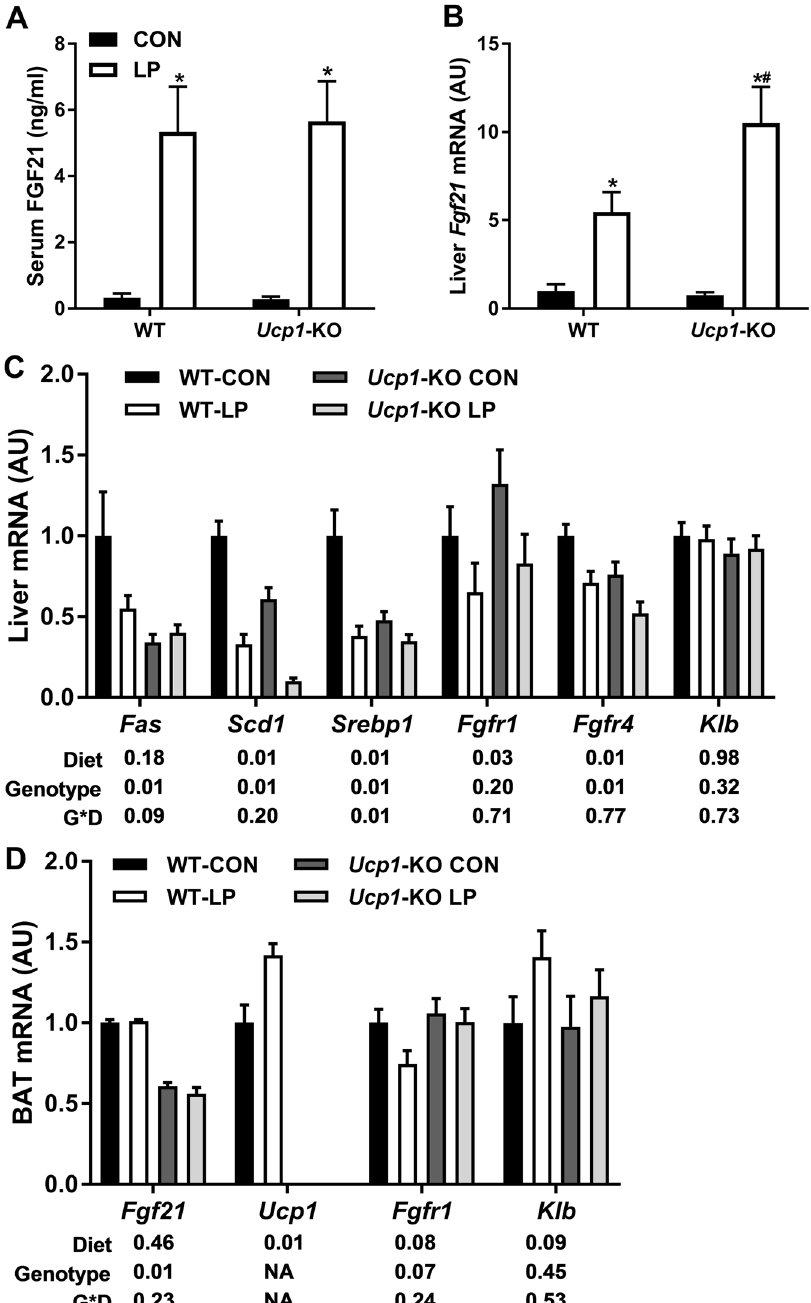
Figure 3. Effect of low protein on FGF21 and liver and BAT metabolic gene expression in Ucp1- KO mice. Tissues were collected from wildtype and Ucp1- KO mice after consuming control or LP diet (8/group) for 6 weeks. Serum FGF21 was measured via ELISA ( A ), while liver Fgf21 ( B , C ) and BAT ( D ) gene expression was measured via real-time PCR. * P < 0.05 LP vs respective control; + P < 0.05 WT-CON vs. Ucp1- CON; # P < 0.05 WT-LP vs. Ucp1- LP. Probability values for the two-way ANOVA main effects of diet and genotype, and their interaction (G * D) are provided below the respective mRNA in C and D